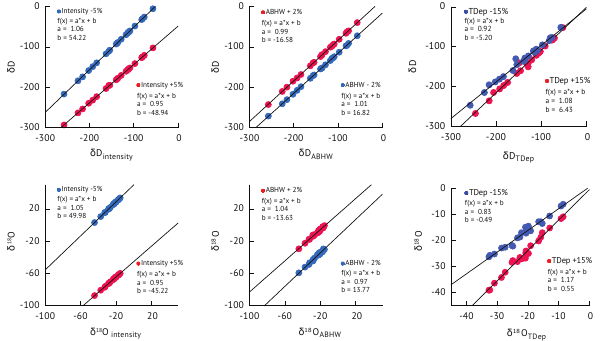
Figure 8. Change in δ D and δ 18 O due to a change of the spec- troscopic line intensities by ± 5% (left panels), due to a change of air-broadened half widths (ABHW) by ± 2% (middle panels) and due to a change of the coefficients of temperature dependence of air-broadened half width by ± 15% (right panels).